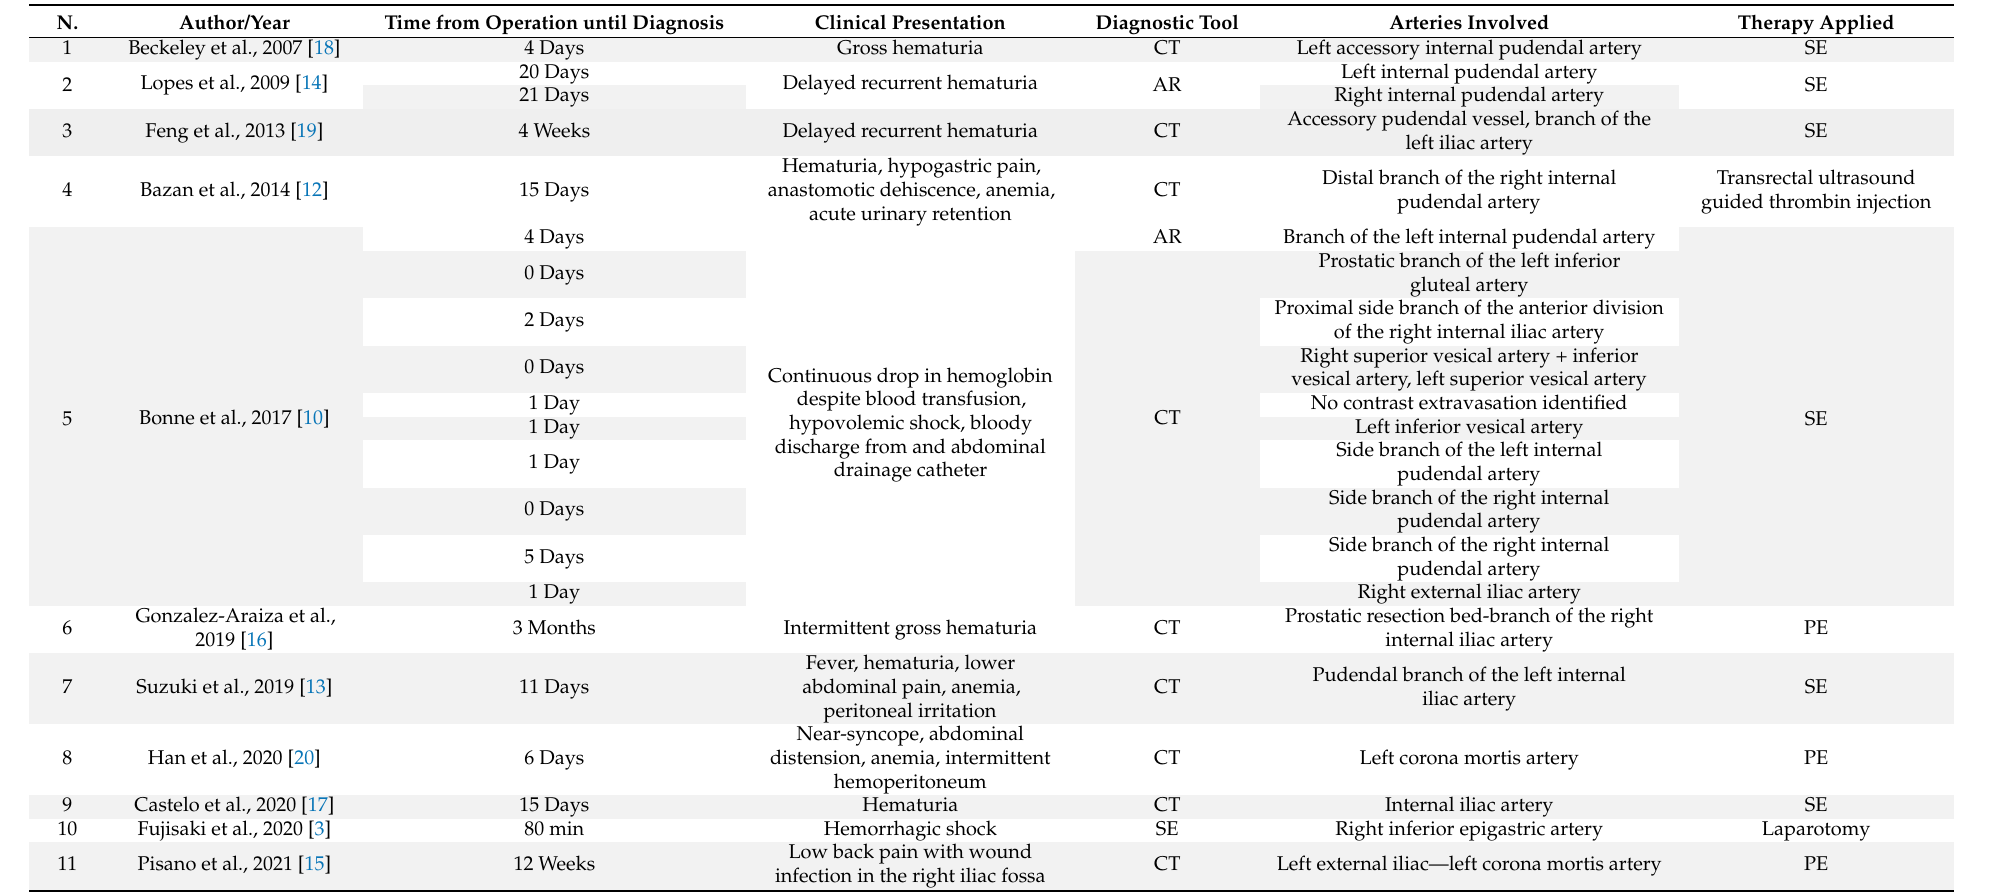
Table 2. Summary of the works reviewed. Clinical data of the patients analyzed: time interval between operation and evaluation of pseudoaneurysm, clinical presentation, imaging exams required to perform diagnosis, artery involved and treatment applied. CT = computed tomography ; AR = arteriography ; SE = surgical exploration ; SE = selective embolization ; PE = percutaneous embolization